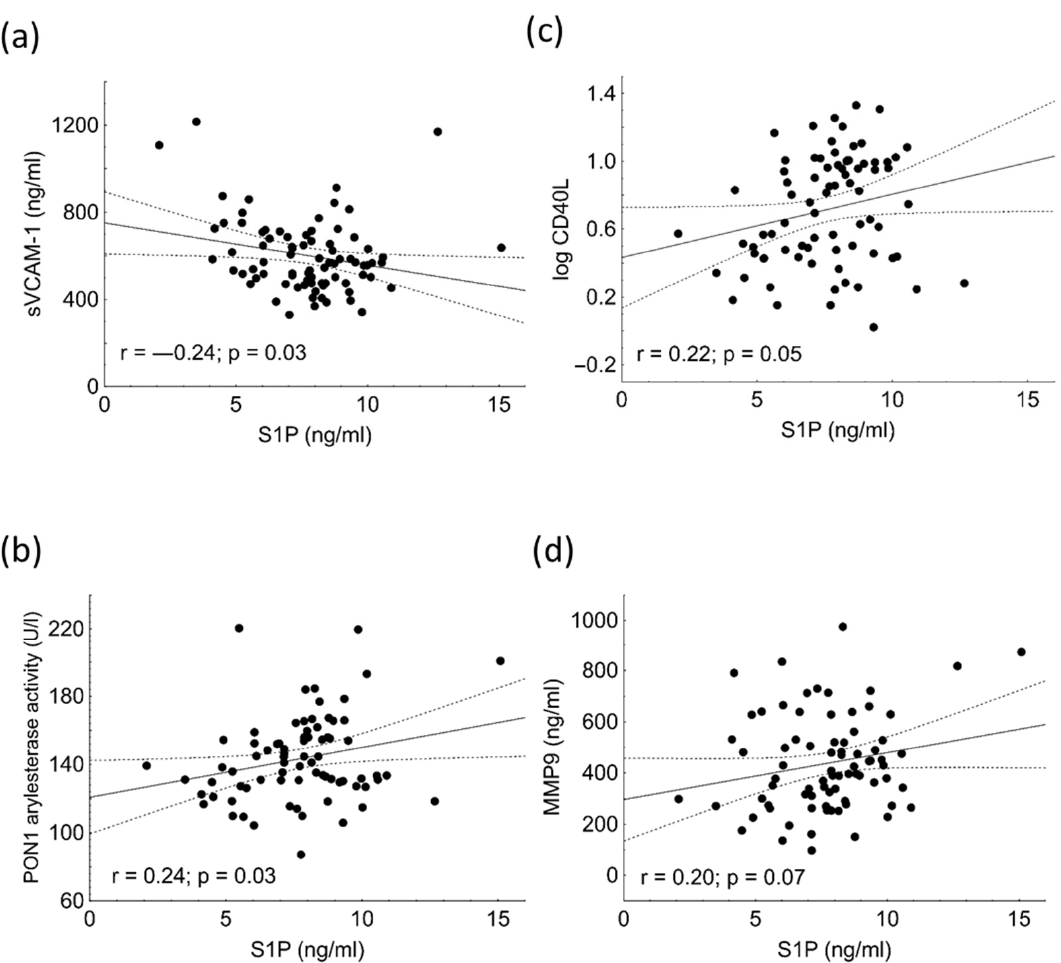
Figure 3. Correlations among sVCAM-1 ( a ), PON1 arylesterase activity ( b ), serum concentrations of logCD40L ( c ), MMP-9 ( d ), and sphingosine 1-phosphate (S1P) in heterozygous familial hypercholesterolemic (HeFH) patients.